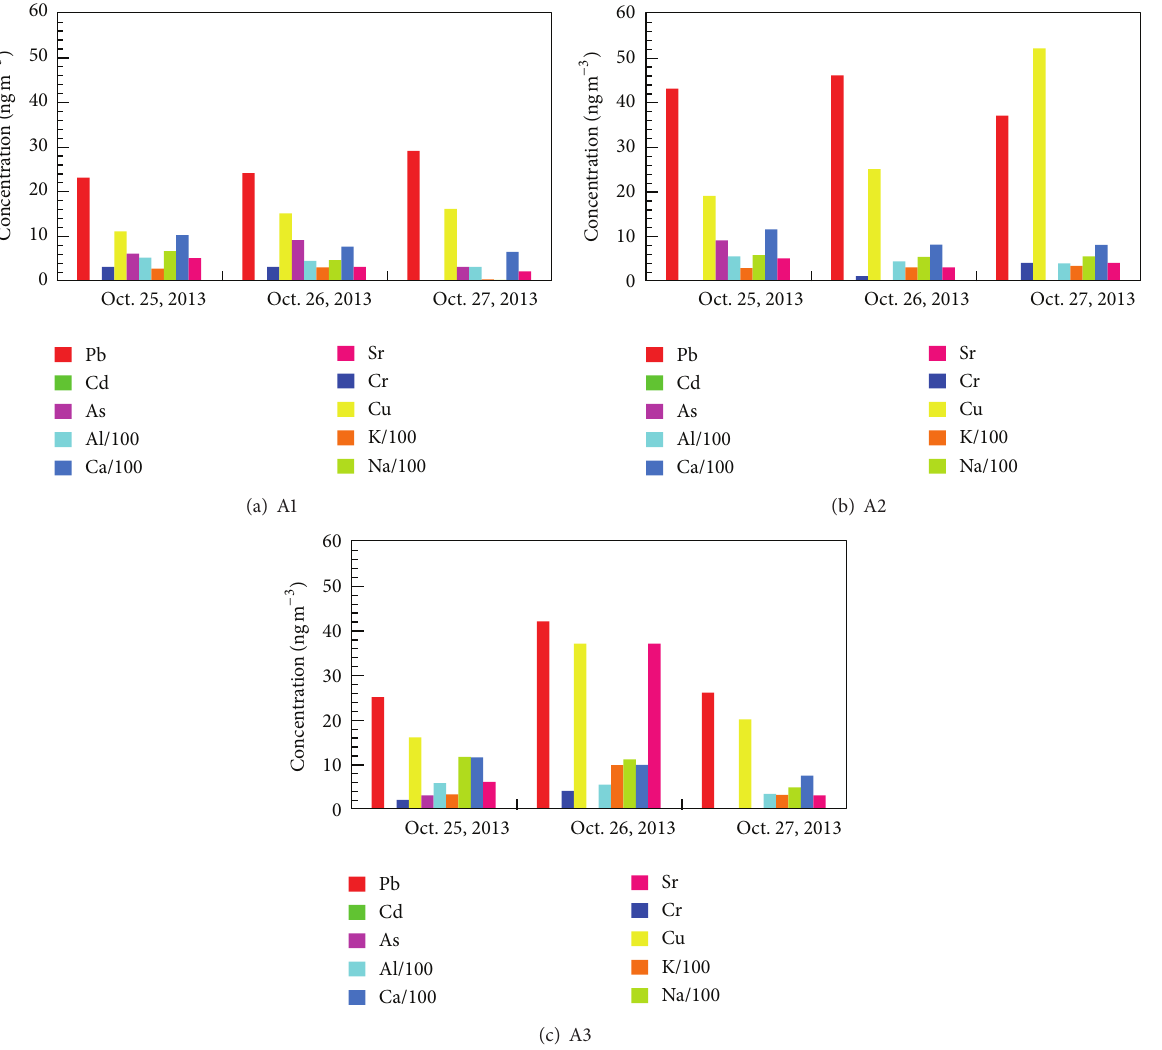
Figure 6: Concentrations of metals and elements during the Busan Fireworks Festival event (Oct. 26) in 2013, measured at three monitoring sites (A1–A3). The concentrations of K, Ca, Al, and Na were scaled down by a factor of 100.